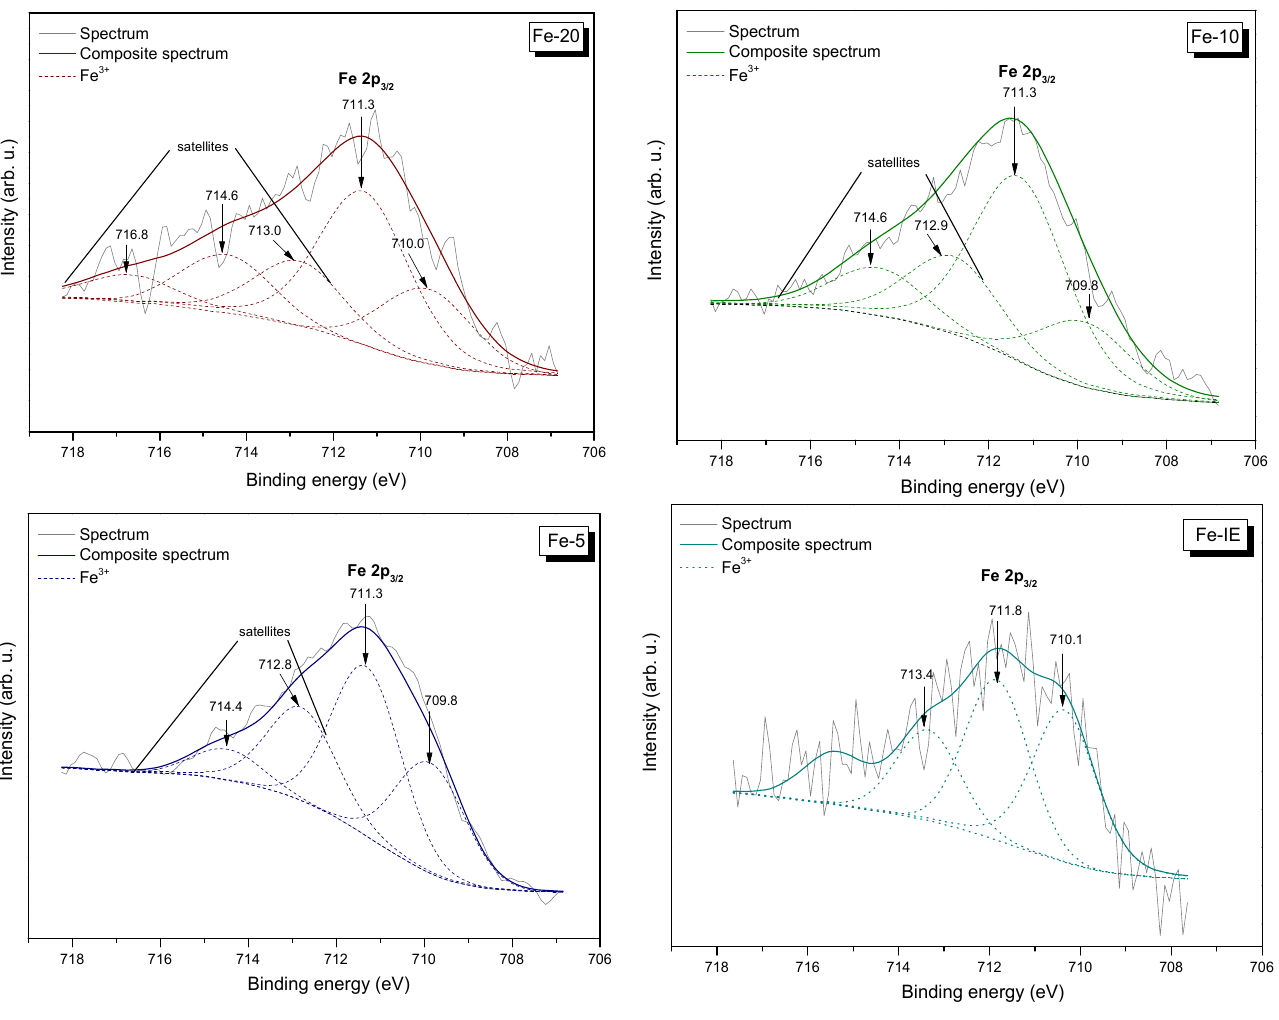
Figure 10. Fe 2p 3/2 XP spectra of the catalysts. Table 5. The values of binding energy (eV) and relative areas of the components in atomic % of